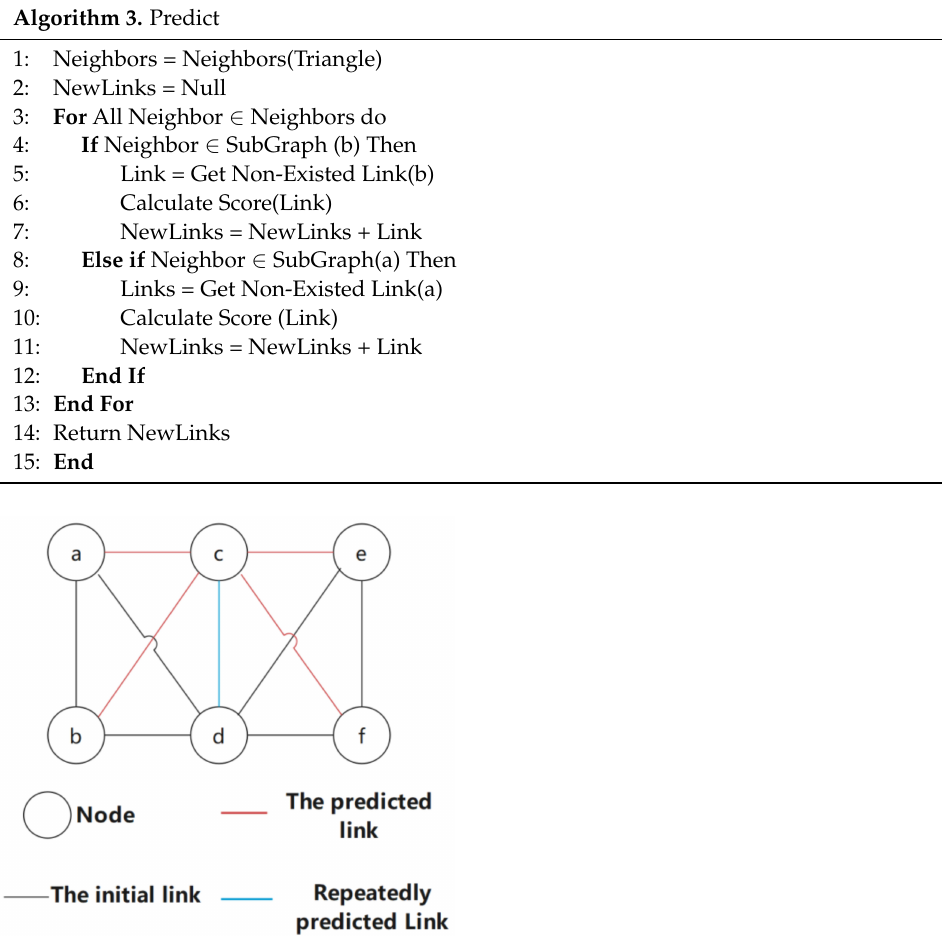
Figure 4. Overlapping links between two subgraphs